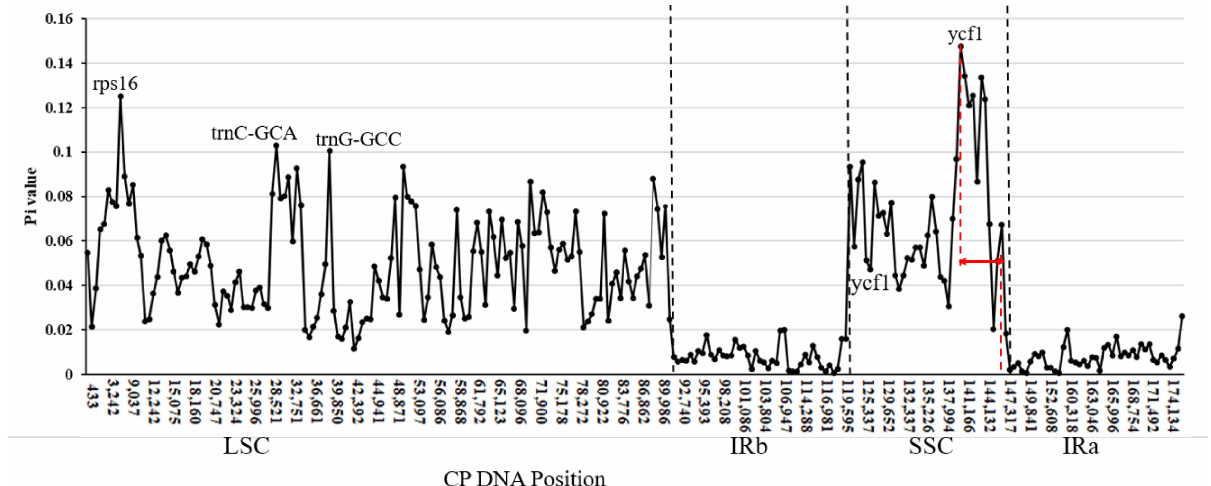
Figure 3. Nucleotide variability (Pi) values among the Laportea species. Peak regions with a Pi-value of > 0.10 were tagged with locus tags of genic or intergenic region names. The red arrows show the length range spanned by the protein-coding sequences of ycf